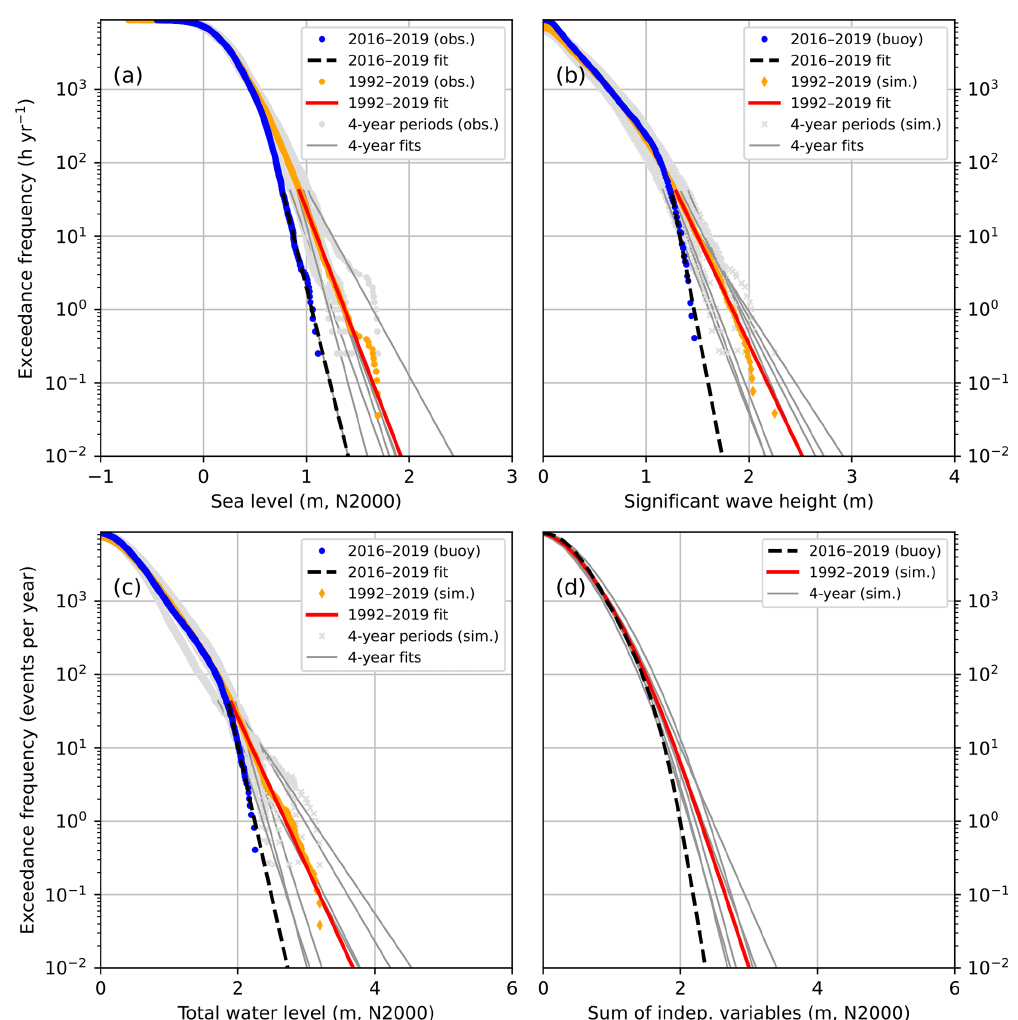
Figure B3. The CCDFs of (a) observed hourly sea levels, (b) observed/simulated significant wave heights, (c) total water level as their sum, and (d) total water level calculated as a sum of two independent variables. The distributions shown are those for the data set I (ice time included). The distributions were extrapolated with exponential functions below the exceedance frequency of 44hyr − 1 . The